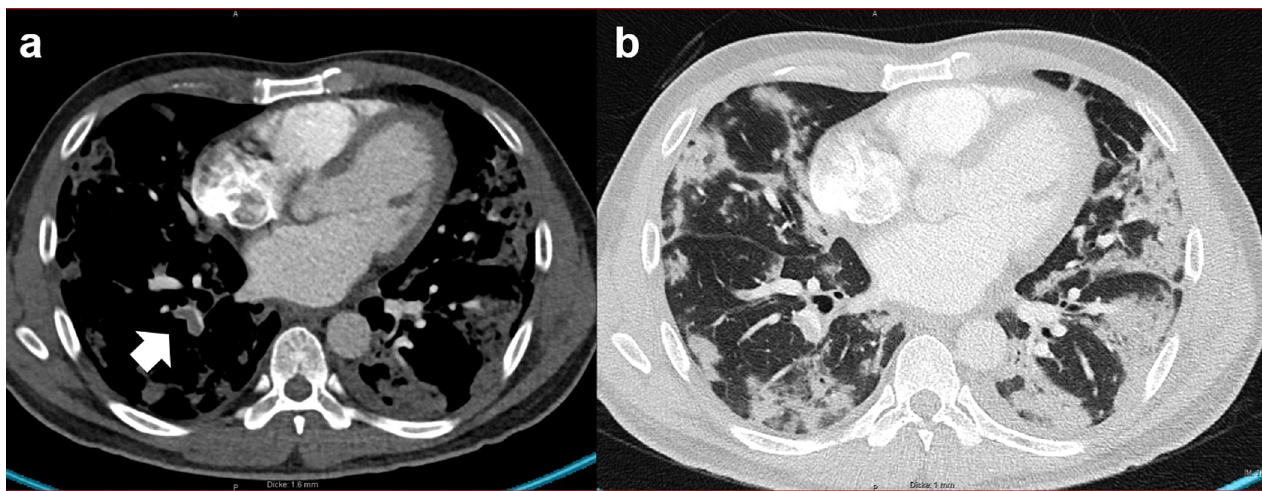
Fig 3. Pulmonary embolism and infarct pneumonia. 34-year-old male patient with COVID-19 pneumonia and a) segmental pulmonary embolism (arrow) in the branch of the lower lobe artery. b) shows wedge shape subpleural consolidation resembling the appearance of infarct pneumonia.